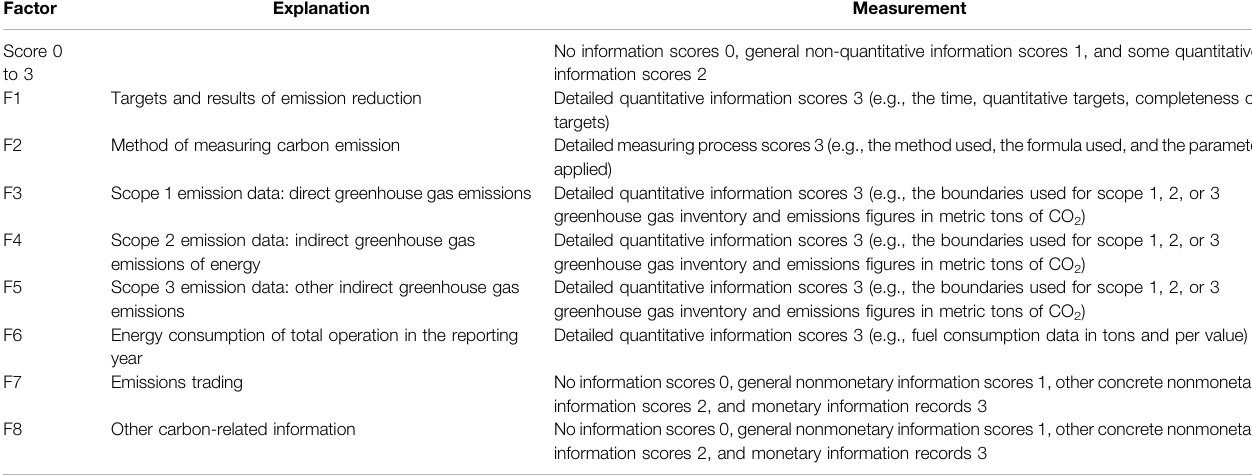
TABLE 2 | Components of CID.